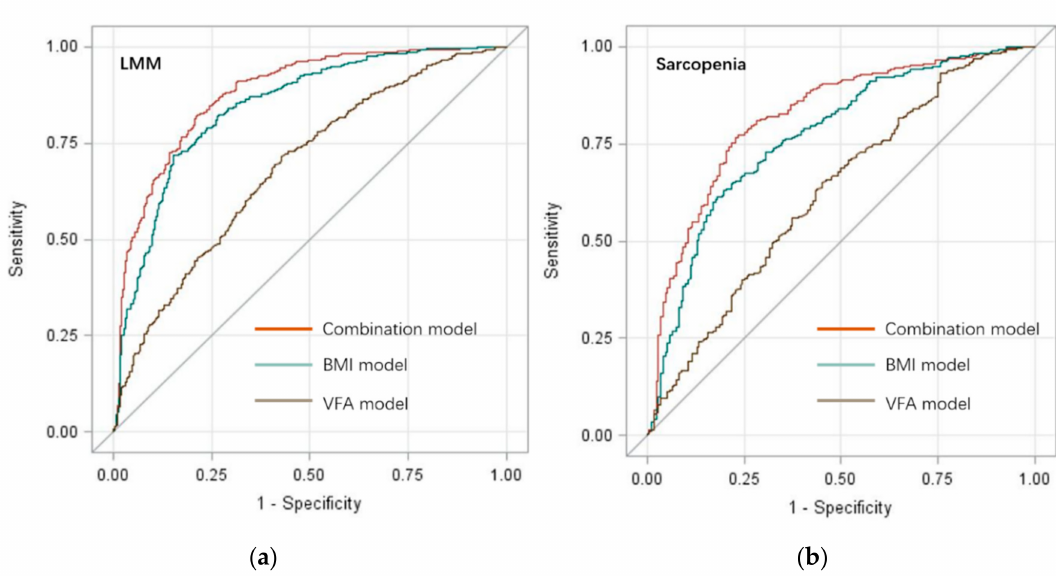
Figure 2. Receiver operating characteristic curves of BMI, VFA, and their combination to predict LMM and sarcopenia in older Chinese people. ( a ) Predict models for LMM; ( b ) Predict models for